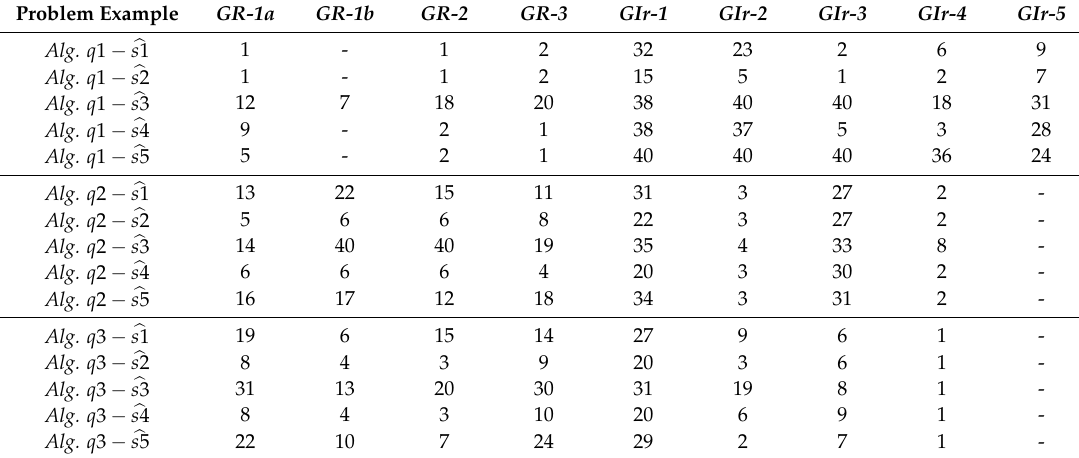
Table 14. Number of admissible solutions